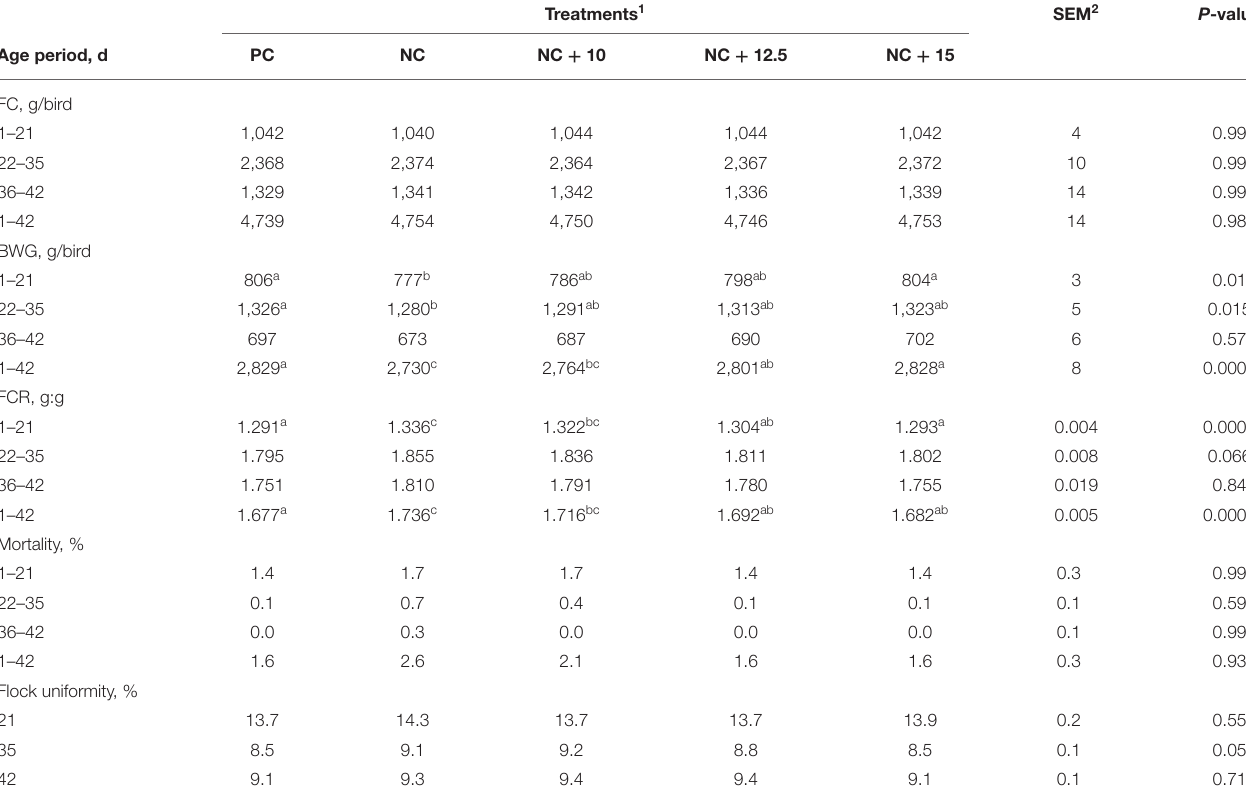
TABLE 2 | Least-squares means for feed consumption (FC), body weight (BW), body weight gain (BWG), feed conversion ratio (FCR), mortality, and BW coefficient of variation for broilers raised to 42 d. Treatments 1 SEM 2 P